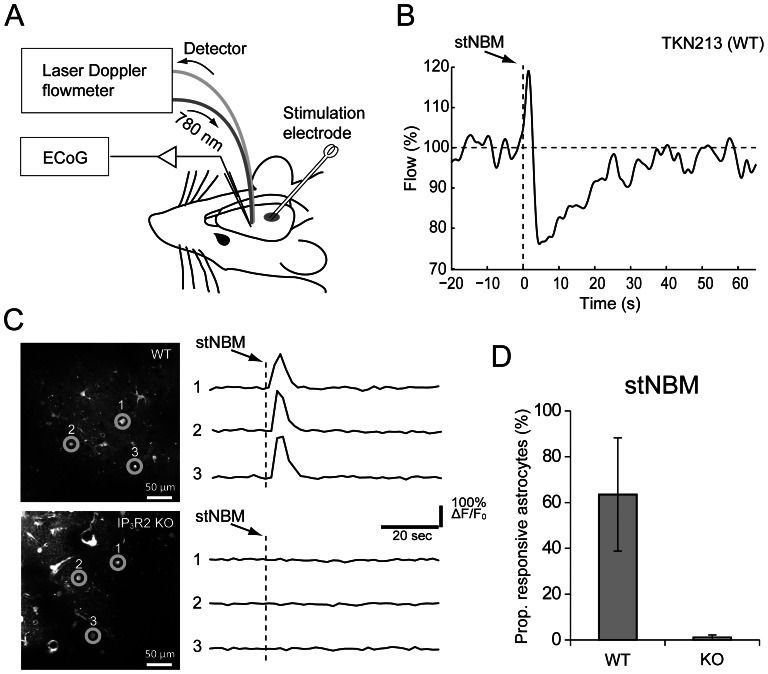
Overview of the stNBM experiment.(A) Sketch for experimental set up. A laser Doppler probe is placed above the thinned skull at the primary somatosensory cortex. A bipolar stimulation electrode is inserted to target the nucleus basalis of Meynert (NBM) in the ipsilateral side. (B) An example trace of laser Doppler flowmetry from a wild type mouse in response to a single train NBM stimulation (stNBM, arrow). (C) In vivo two-photon imaging of Fluo-4 AM loaded astrocytes in the somatosensory cortex of C57BL/6J (WT, upper panels) and IP3R2-KO (lower panels). (D) Proportion of barrel cortex astrocytes that elicited Ca2+ elevations upon stNBM.